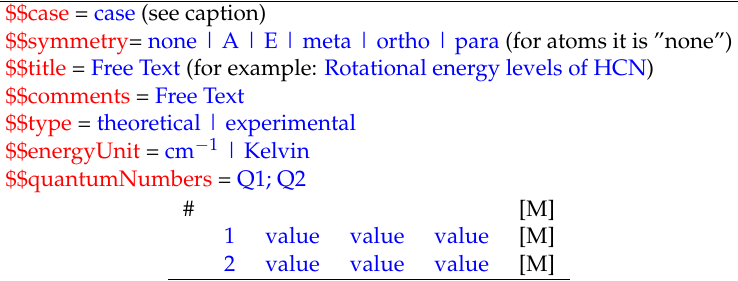
Table A3 provides a template of an “Energy Origin” input; it includes the metadata of Table